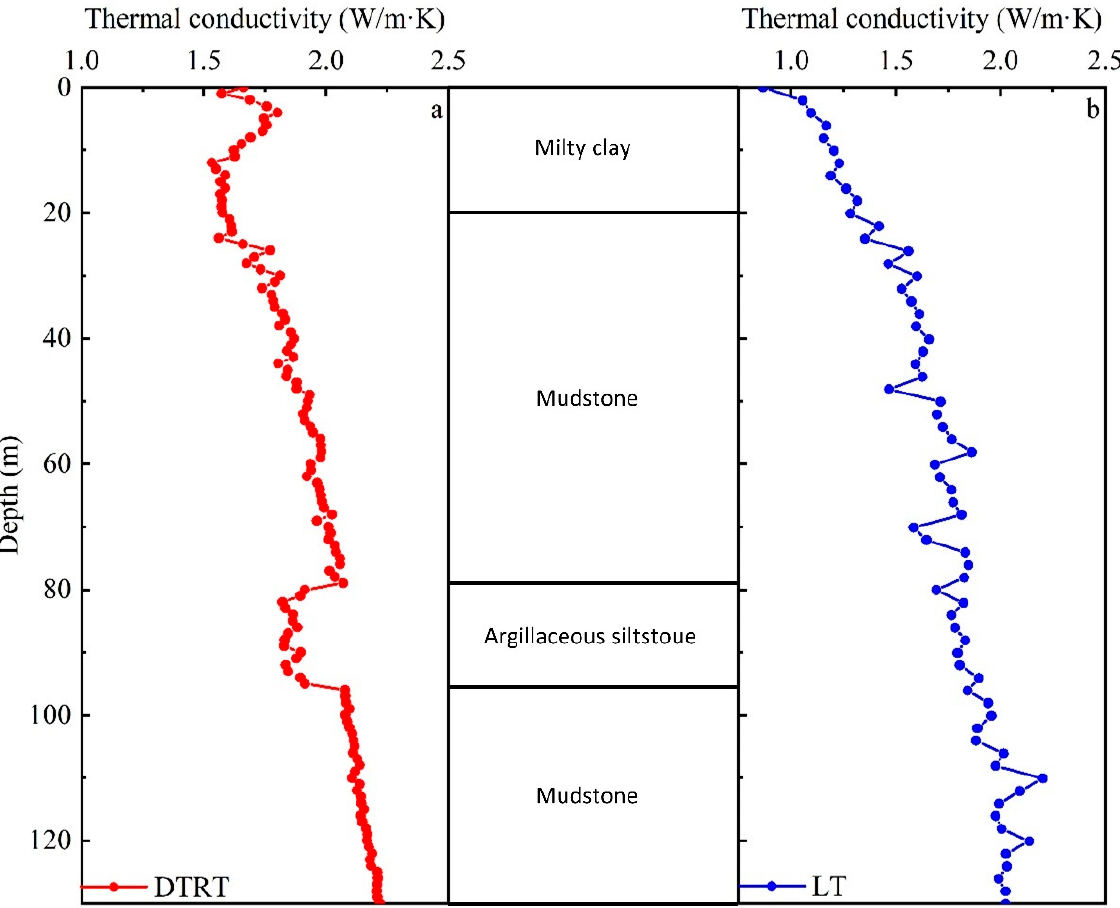
Figure 8. Thermal conductivity with depth. ( a ) Thermal conductivity of the DTRT module. ( b ) Ther- mal conductivity of LT.